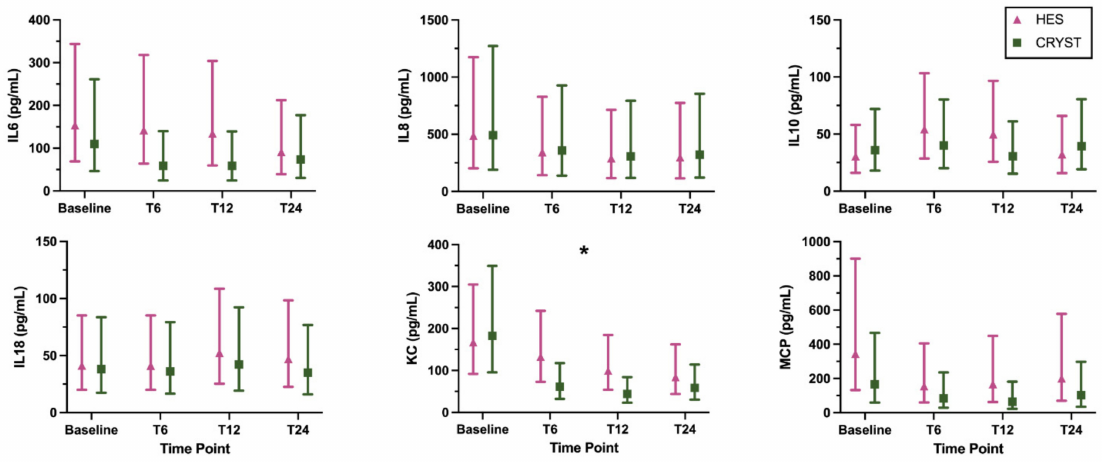
Figure 2. Inflammation biomarkers (geometric mean, 95% confidence interval) in dogs randomized to receive 6% hydroxyethyl starch 130/0.4 (HES) or Hartmann’s solution (CRYST). * indicates a significant ( p < 0.05) change over time where both groups are considered together. Abbreviations: IL6, interleukin 6; IL8, interleukin 8; IL10, interleukin 10; IL18, interleukin 18; KC, keratinocyte-derived chemokine; MCP, monocyte chemoattractant